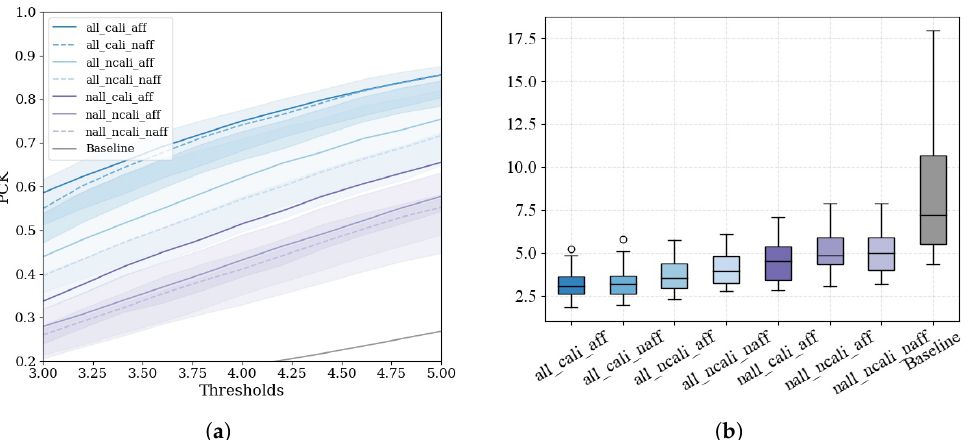
Figure 6. Comparison between the different protocols and paradigms by two metrics. ( a ) Comparison of PCK curve. The horizontal axis unit is cm. ( b ) Comparison of Euclidean error. The vertical axis unit is